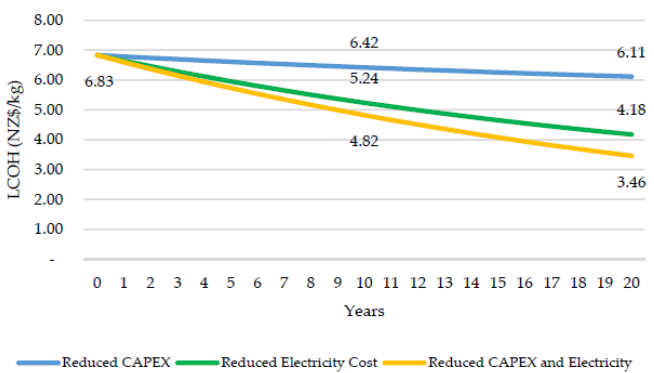
Figure 6. Hydrogen cost reduction